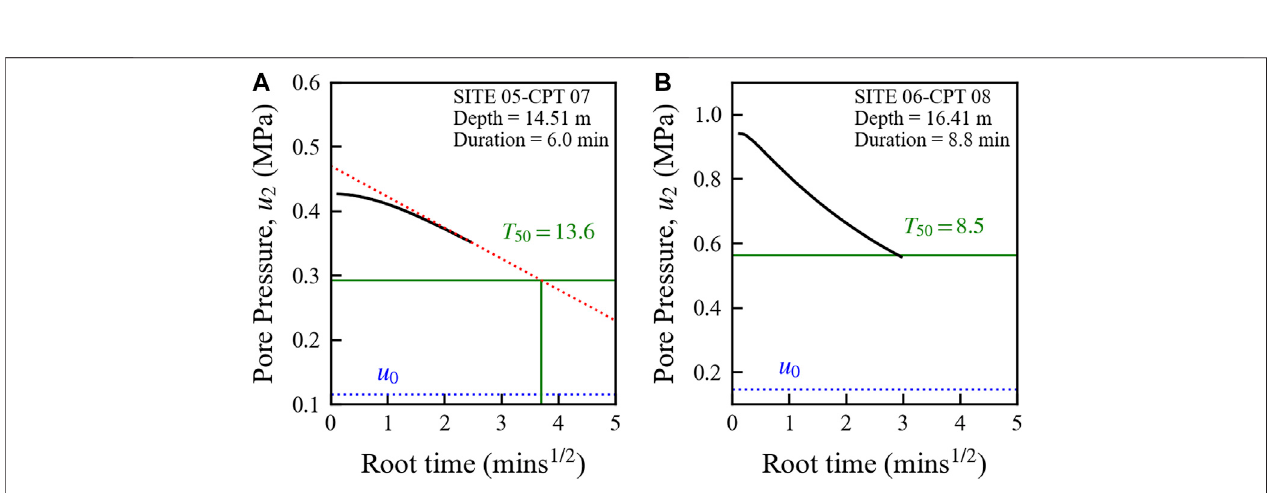
FIGURE 7 | Dissipation testing against the square root of time at (A) site 05, Satdobato agricultural fi eld and (B) site 06, Chyasal bus depot.